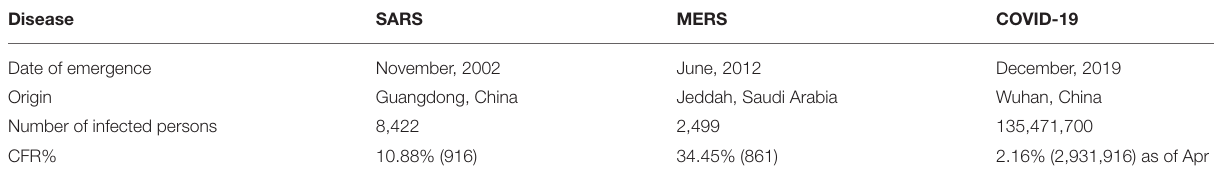
TABLE 1 | Severe acute respiratory syndrome (SARS), Middle East respiratory syndrome (MERS), and coronavirus disease 2019 (COVID-19). Disease